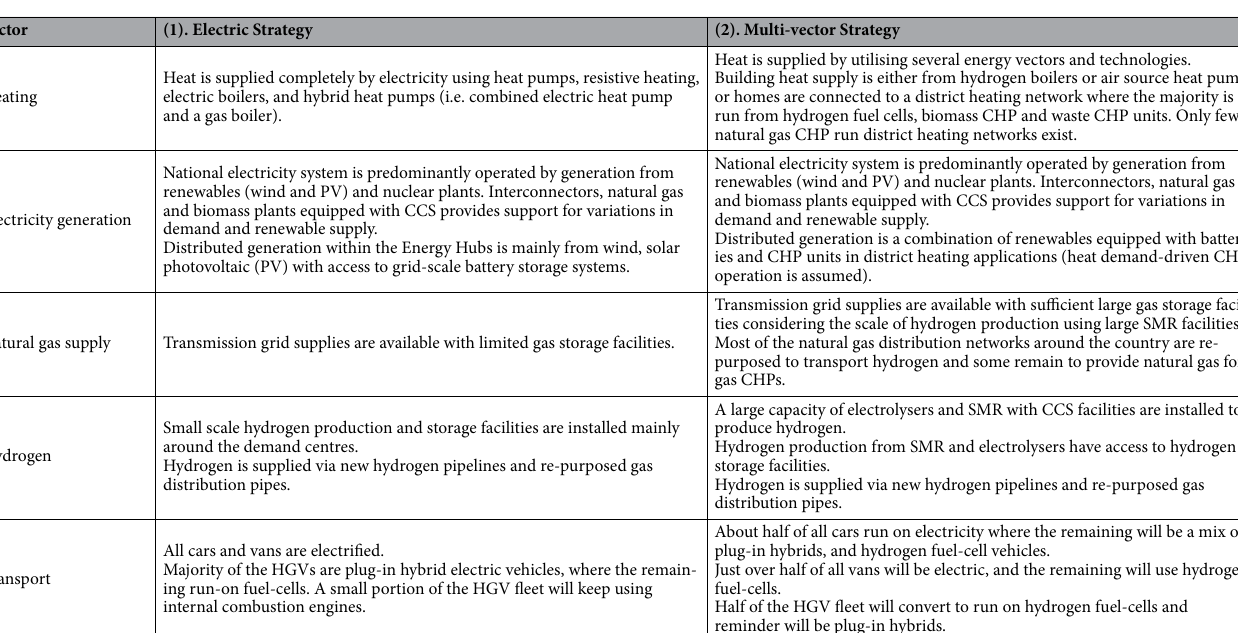
Figure 3. ( a ) Electricity and natural gas transmission network representation, and energy hub geographical regions representing local energy systems of Great Britain ( b ) Outline of energy supply strategies in 2050 defined through a combination of heat and transport decarbonisation options for centralised and decentralised operation.